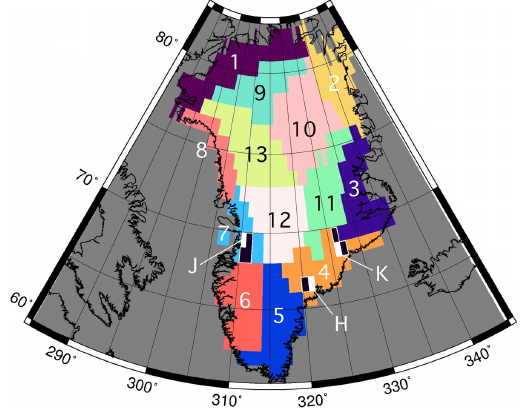
Figure 2. SMB and glacial basins for Greenland. Glacial basin (J)akobshavn overlaps with SMB basin 7, while (H)elheim and (K)angerdlugssuaq overlap basin 4. White grid cells show the cen- tral glacier cell, while black are lesser-weight glacier